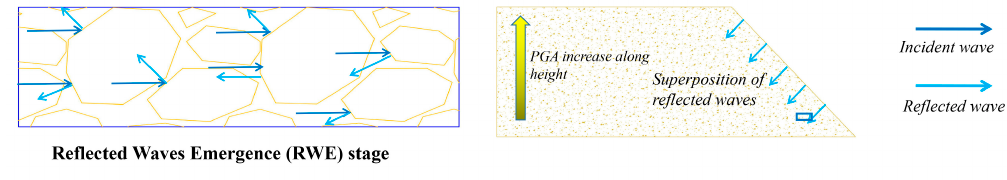
Figure 12. Relationship between HAM and input peak acceleration.